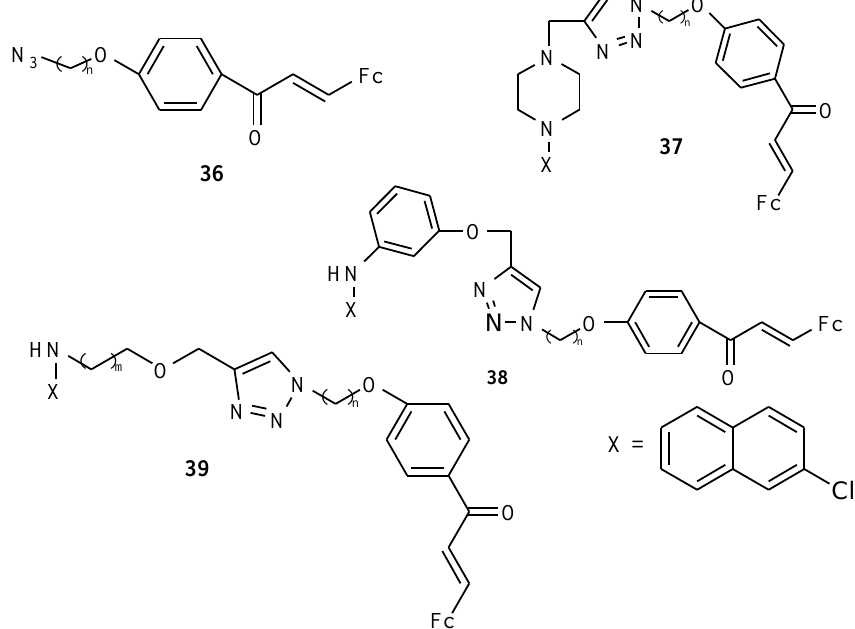
Figure 16. Chemical structures of O -alkyl azide ferrocenylchalcones ( 36 ); piperazine ( 37 ), phenyl ( 38 ), amino alcohol ( 39 ) – linked 7-chloroquinoline-ferrocenylchalcone derivatives.